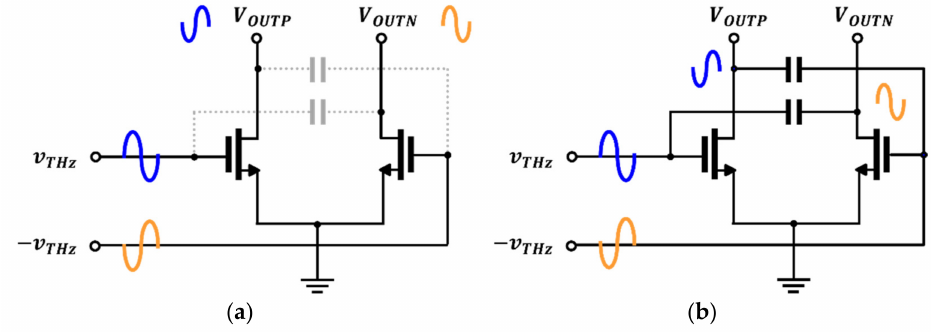
Figure 2. Two operations in the proposed circuit: ( a ) gate input topology; ( b ) drain input